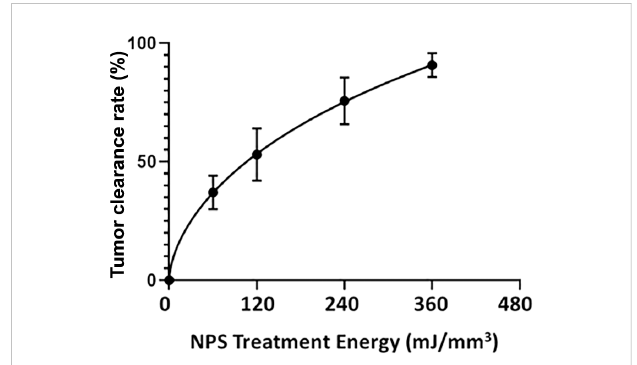
FIGURE 2 The percentage of treated tumors that are completely cleared as a function of the energy applied during treatment. Bars represent the Standard Error of the Mean.